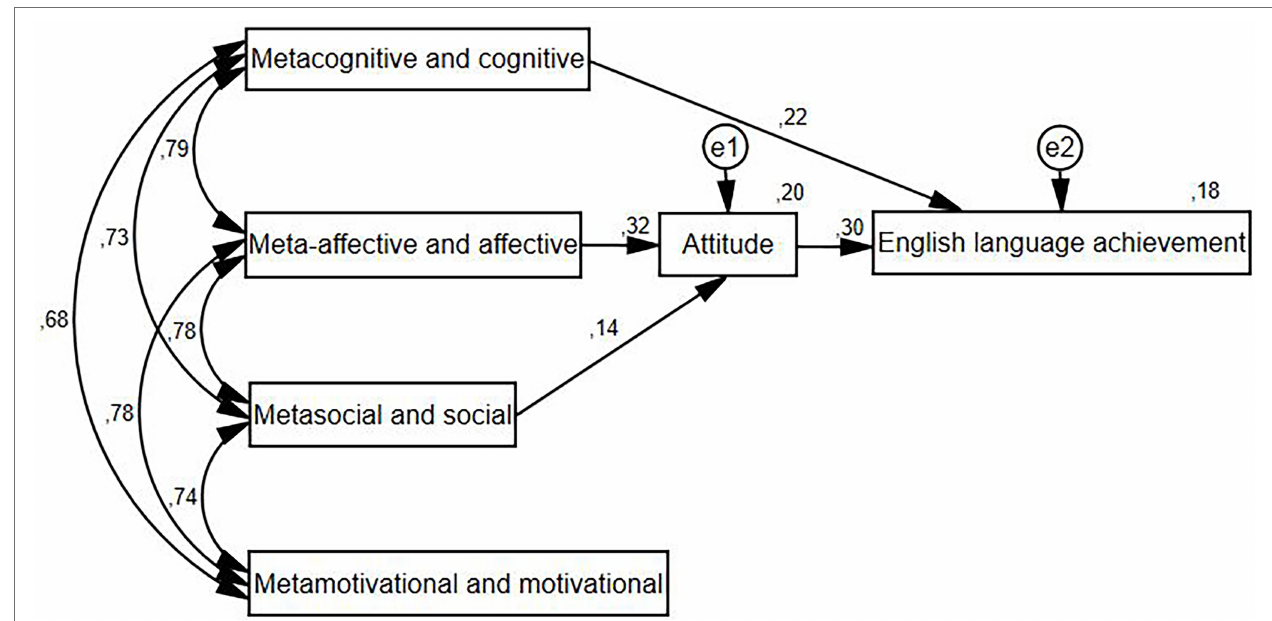
FIGURE 1 | The path model for EFL strategies on English language achievement through